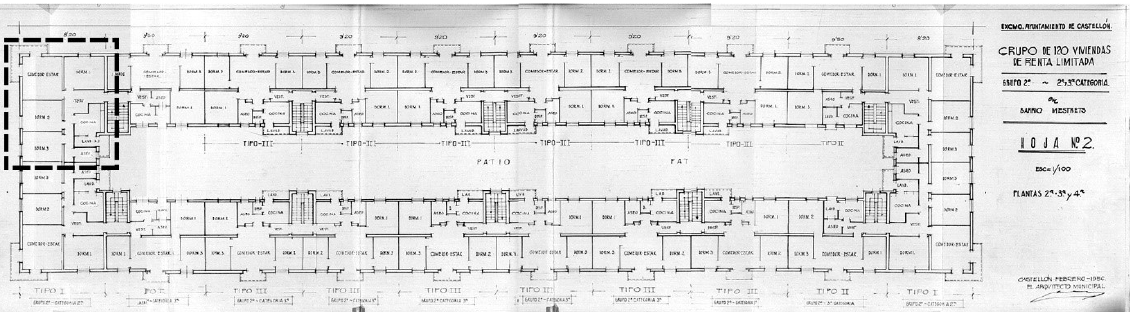
Figure 6. Second Floor (Original plans)